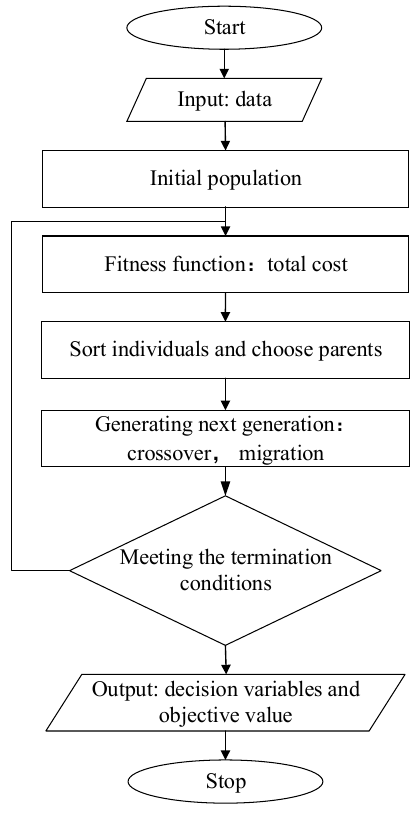
Figure 3. The genetic algorithm procedures.